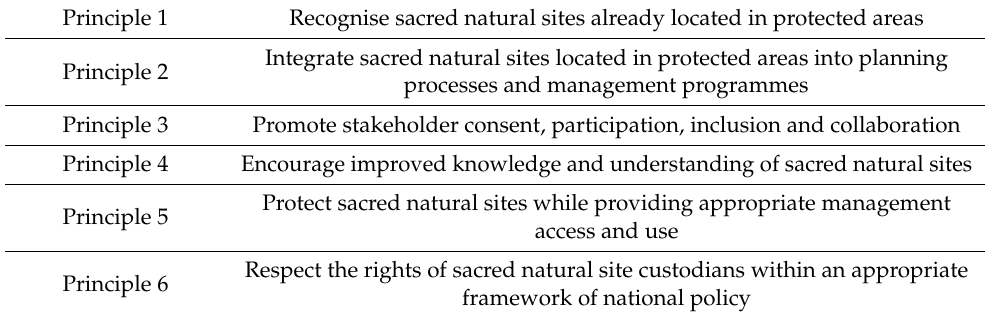
Table 4. The six principles of the IUCN UNESCO Guidelines on sacred natural sites [2] (p.